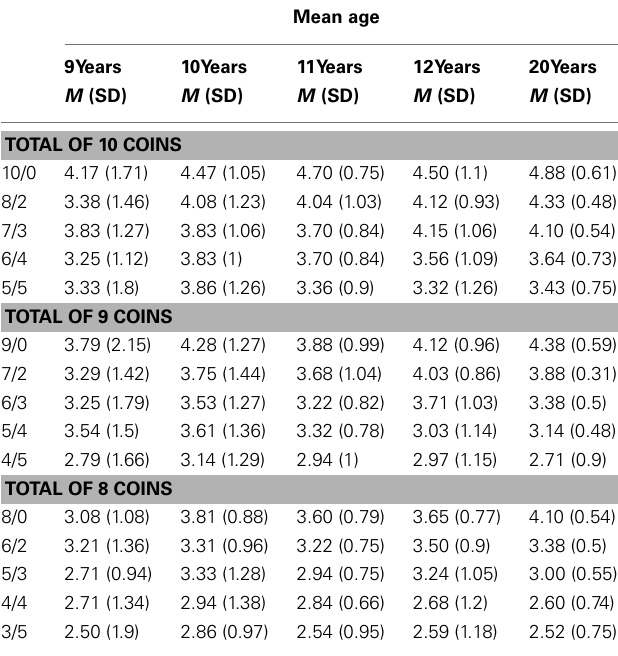
Table 2 | Descriptives of mean offers of the 15 conditions in five age